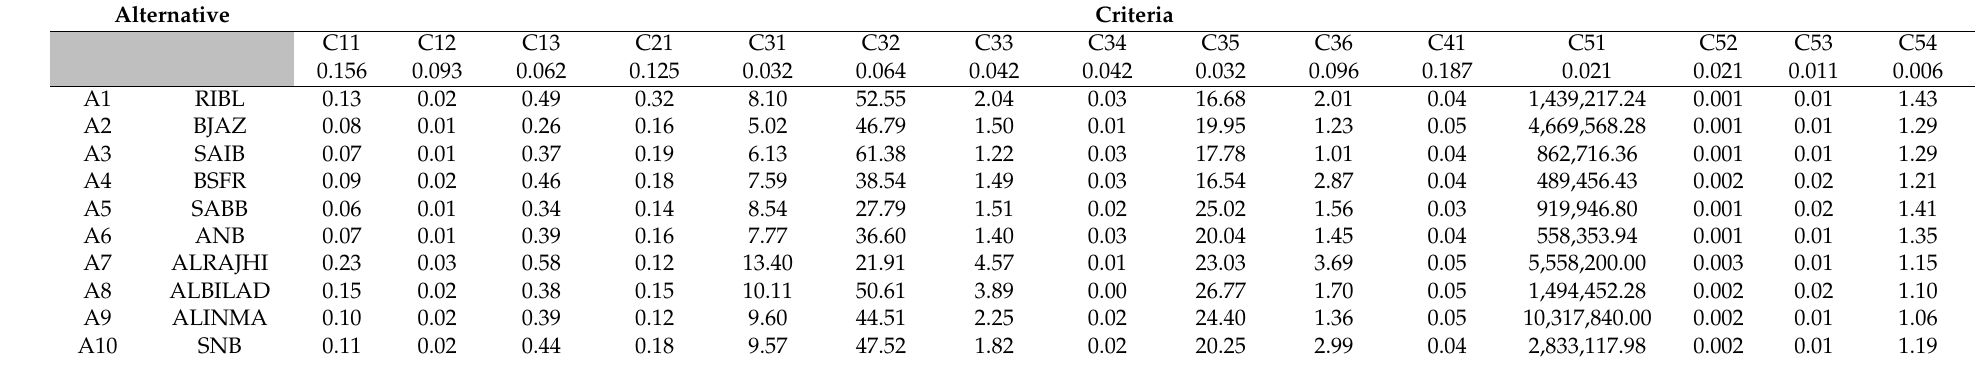
Table 7. Input data used in RAPS